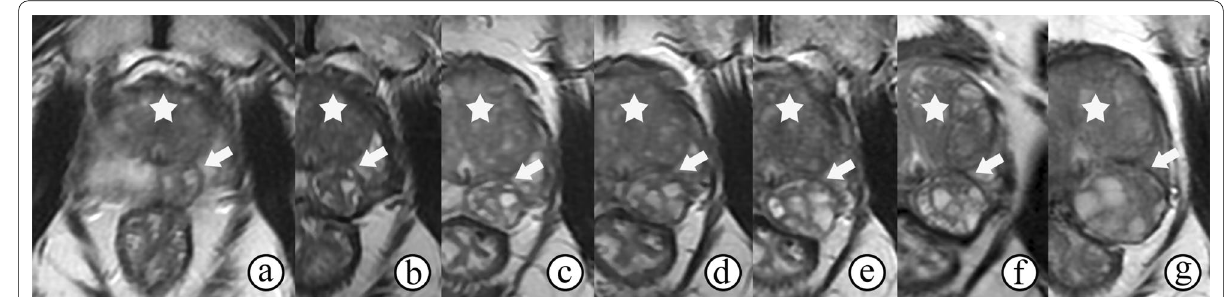
Fig. 1 BPH in a 66-year-old man with an elevated serum PSA level fluctuating from 4 to 10 ng/mL. a–g Axial T2-weighted images captured in Jan 2010 (size of 1.3 cm), May 2012, Mar 2013, Dec 2013, Feb 2015, May 2015, and Jul 2019 (size of 2.6 cm) show a gradually increasing nodule with heterogeneous hyperintensity and a well-defined capsule in the left peripheral zone (arrow), the size of which increases with the progress of BPH in the TZ ( ☆